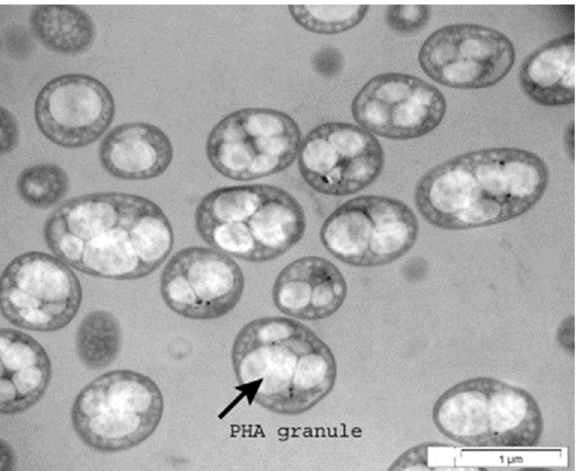
Figure 1. Transmission electron micrograph showing granules of PHA accumulated in the bacterium P. putida CA-3 from styrene [10].